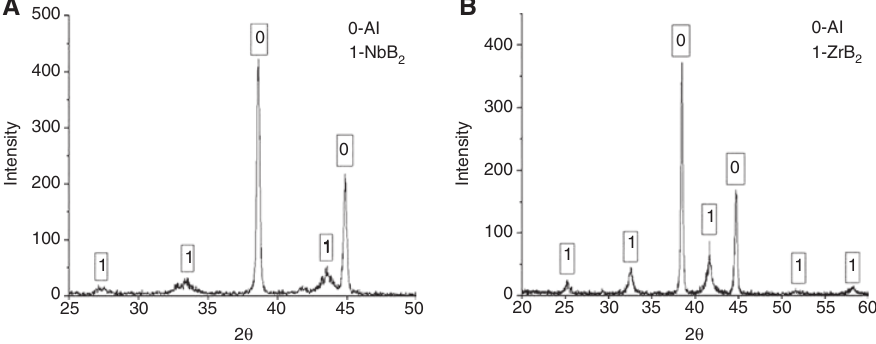
composite pellet after sintering, (B) Al/ZrB 2